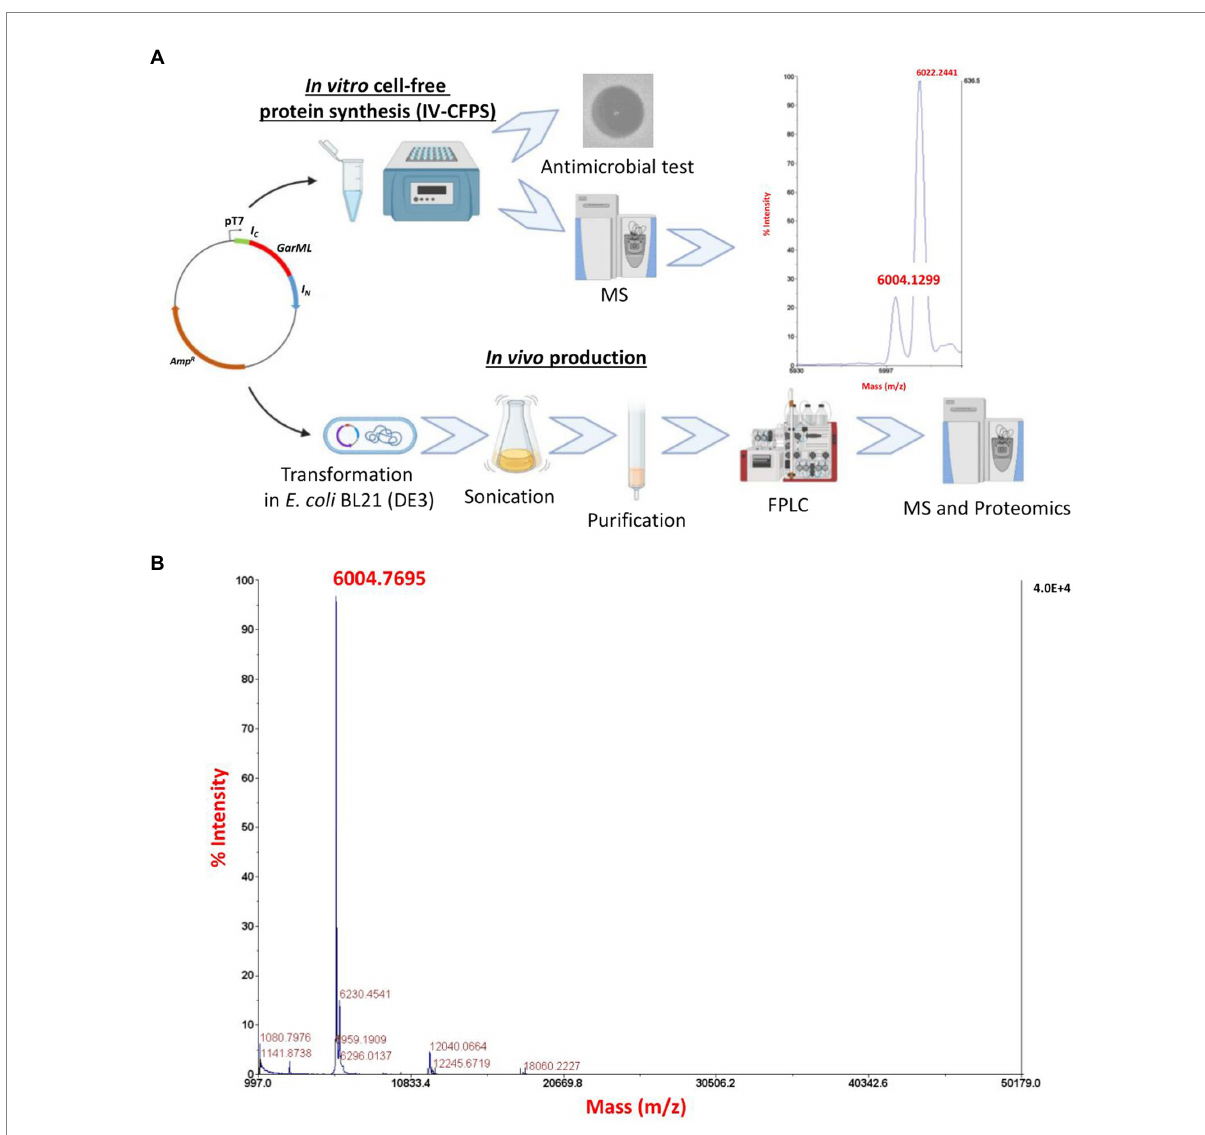
FIGURE 3 (A) Schematic representation of the in vitro and in vivo production and split-intein mediated ligation (SIML) of GarML, evaluation of the antimicrobial activity and MALDI-TOF MS analysis of the in vitro CFPS-produced GarML. (B) MALDI-TOF MS analysis of the in vivo produced GarML in the cellular soluble fraction (CFS) of E . coli BL21 (DE3), transformed with